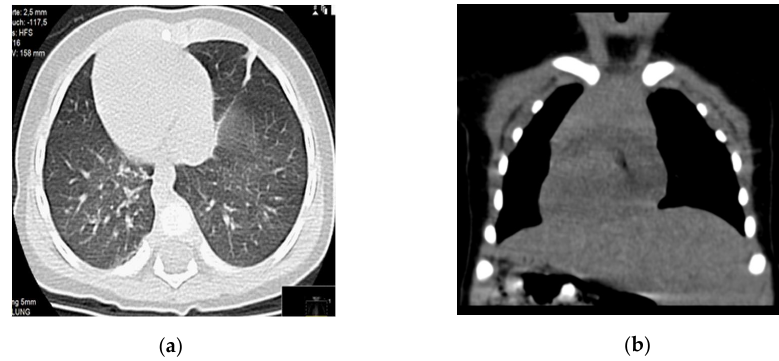
Figure 1. Patient-1 CT scan without contrast. ( a ) Dextrocardia and normal lung parenchyma. ( b ) Dextrocardia and left-sided liver .